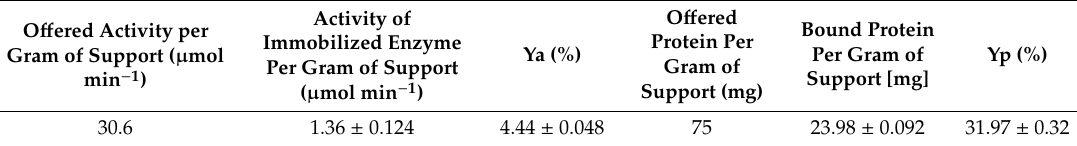
Table 1. Immobilization yields of naringinase on chitosan microspheres. O ff ered Activity per